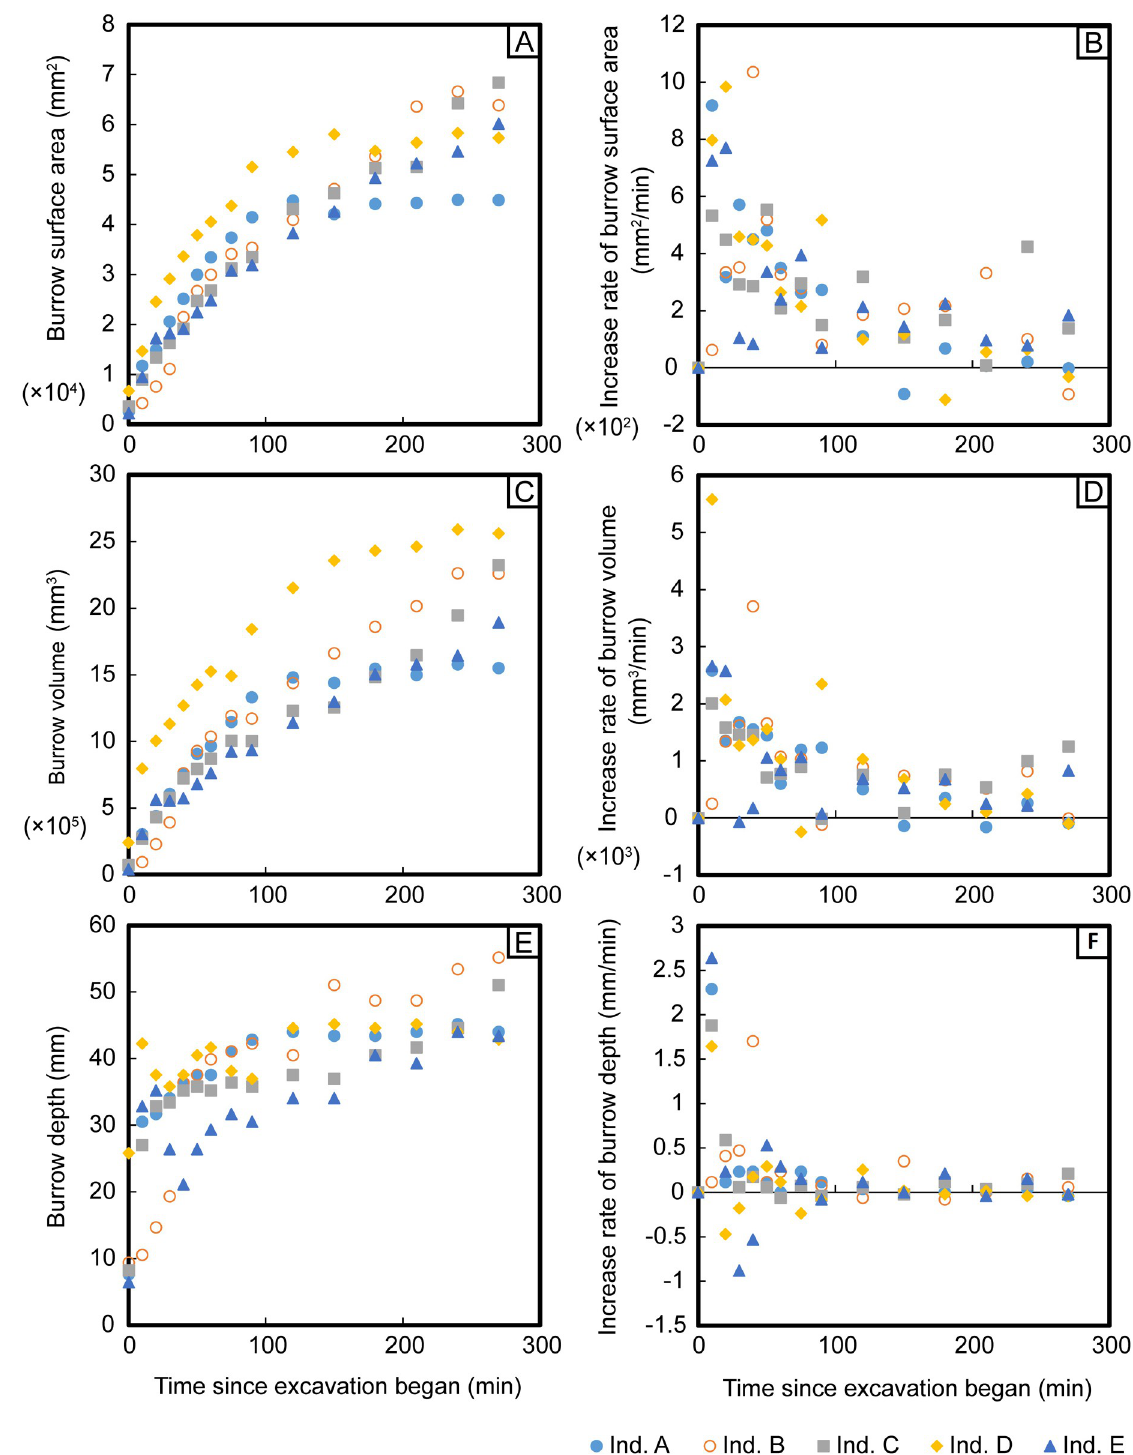
Fig 6. Changes in burrow surface area, volume, and depth over time. Panels show: (A) surface area, (B) the rate of increase of surface area, (C) volume, (D) the rate of increase of volume, (E) depth, and (F) the rate of increase of depth.